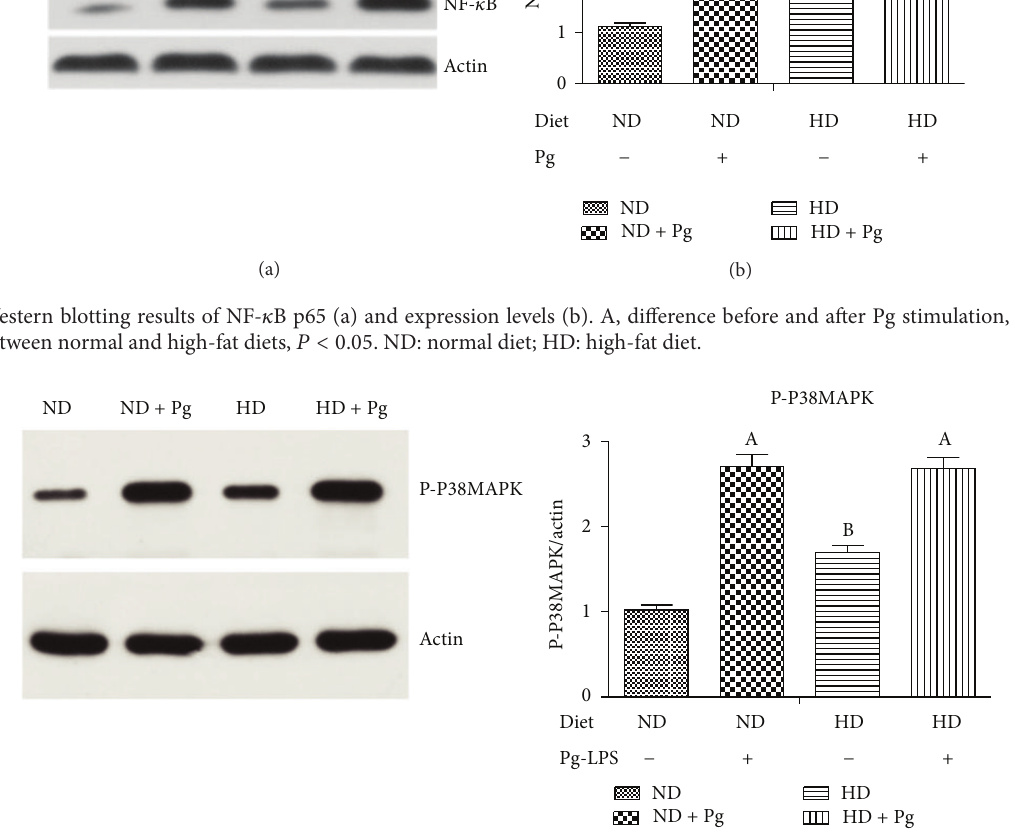
Figure6:Westernblottingresultsofphospho-p38-MAPK(a)andexpressionlevels(b).A,differencebeforeandafterPgstimulation, 𝑃 < 0.05 . ND: normal diet; HD: high-fat diet.